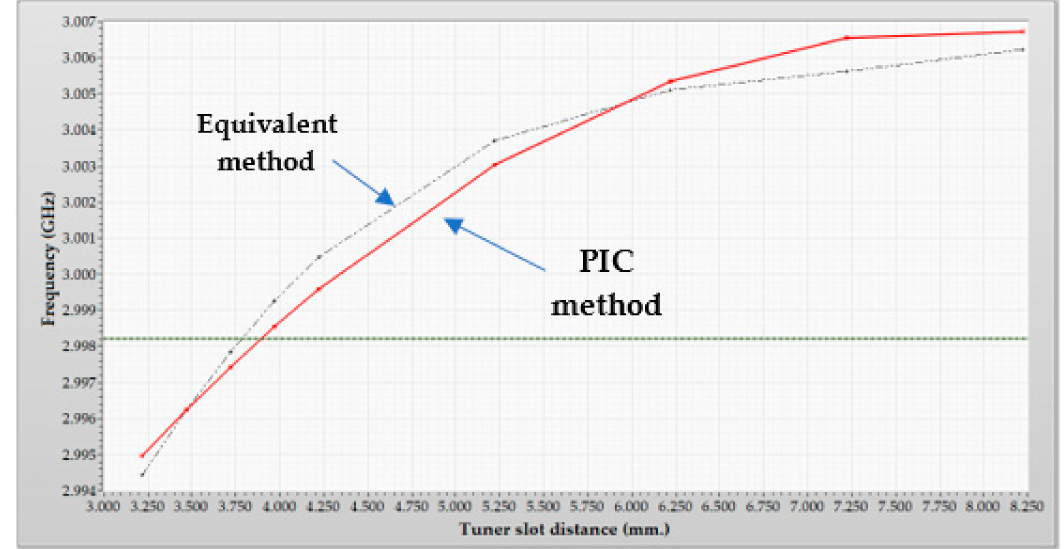
Figure 19. The simulation results of resonant frequency after adjusting tuner slot